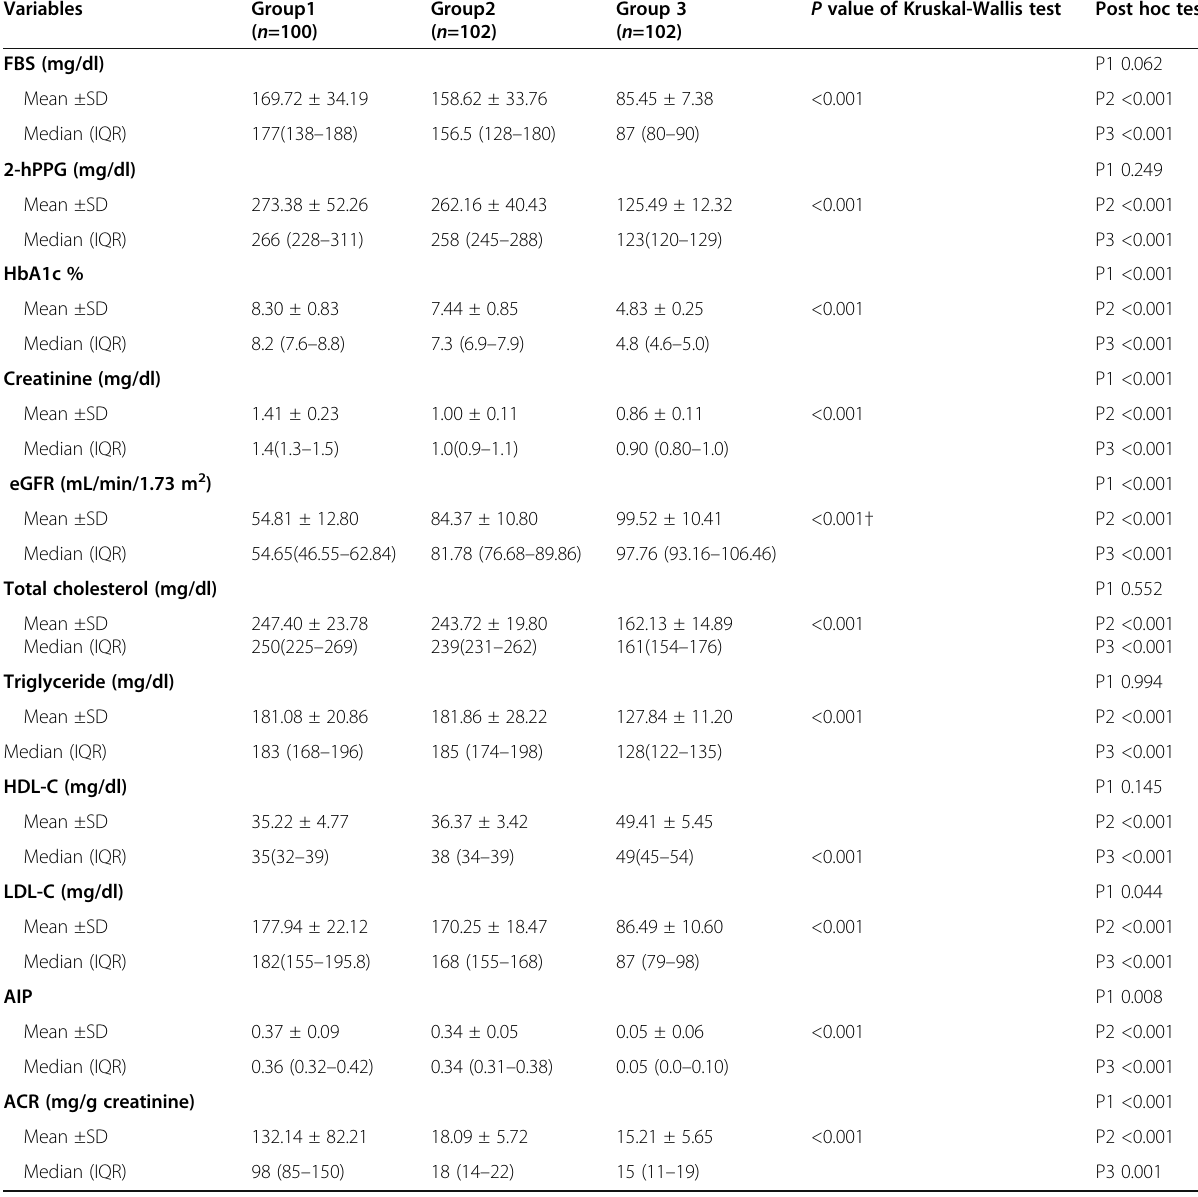
Table 2 Laboratory results of the studied groups